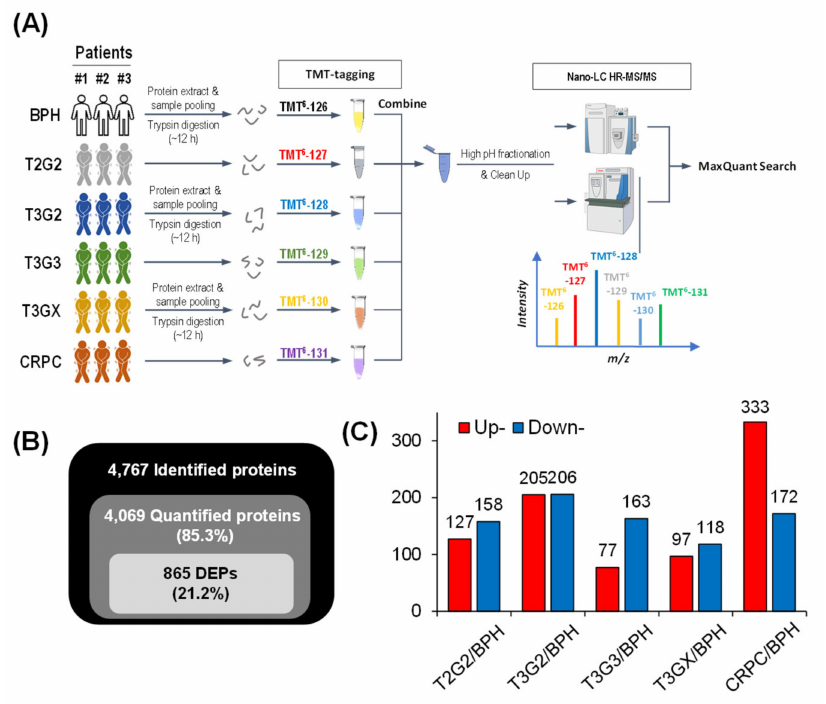
Figure 1. A bottom-up proteomic technique using nano-liquid chromatography–tandem mass spectrometry in six groups of different patients with prostate cancer. ( A ) Proteomic experimental scheme of 6-plex tandem mass tags labeled prostate tissue. ( B ) The basic statistical figure of mass spectrometry results. ( C ) Histogram of the distribution of differentially expressed proteins in different comparison